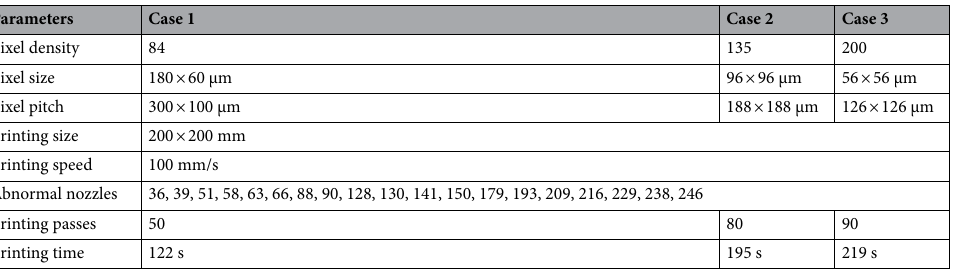
Table 4. Printing parameters for panels with different pixel densities.